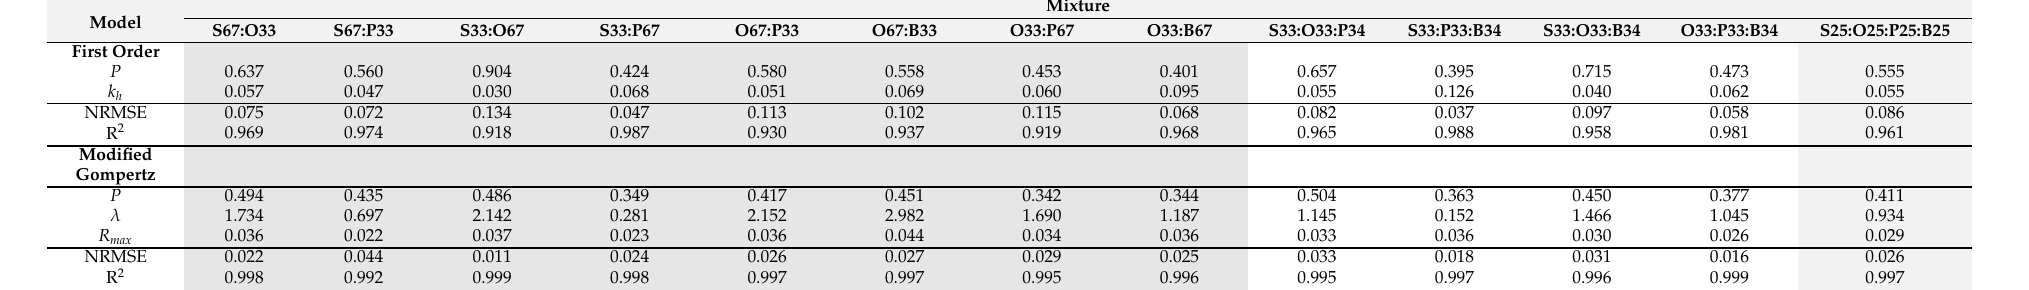
Table 7. Kinetic parameters of the models fitted to the curves of the biochemical methane potential (BMP)